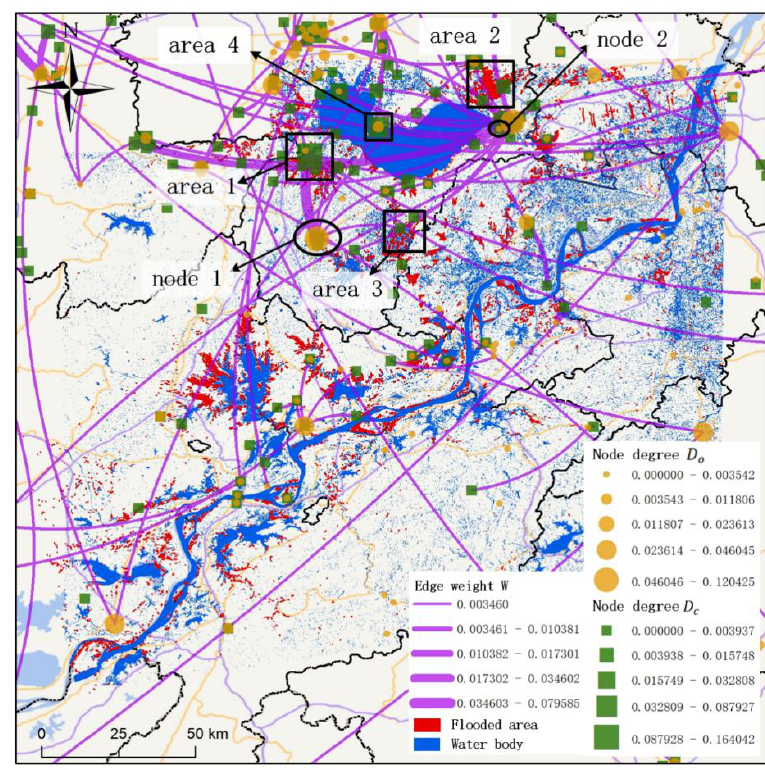
Figure 7. Superposition analysis of multi-source disaster information.